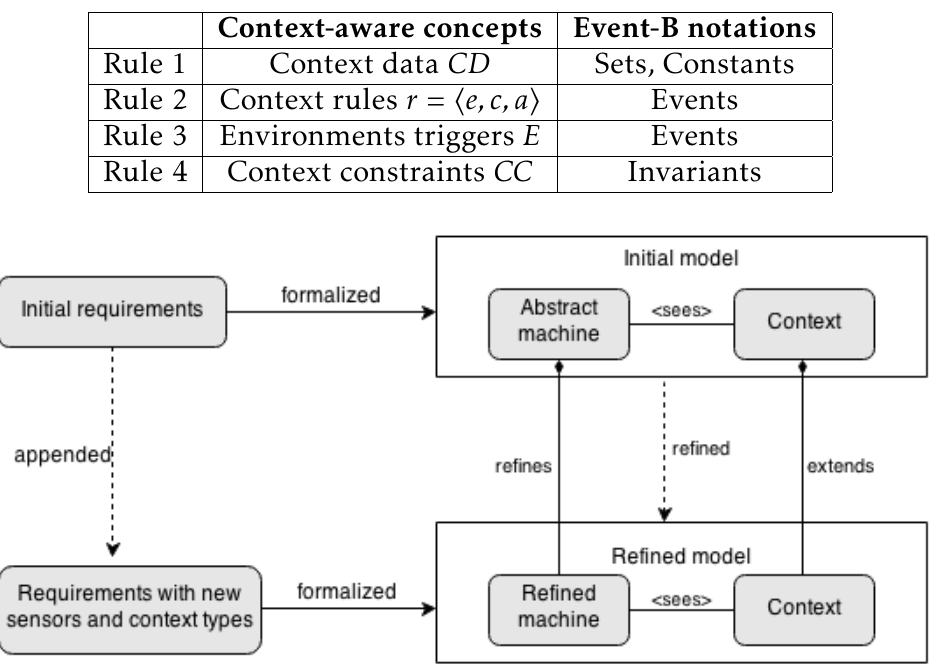
Figure 3. Incremental modeling using